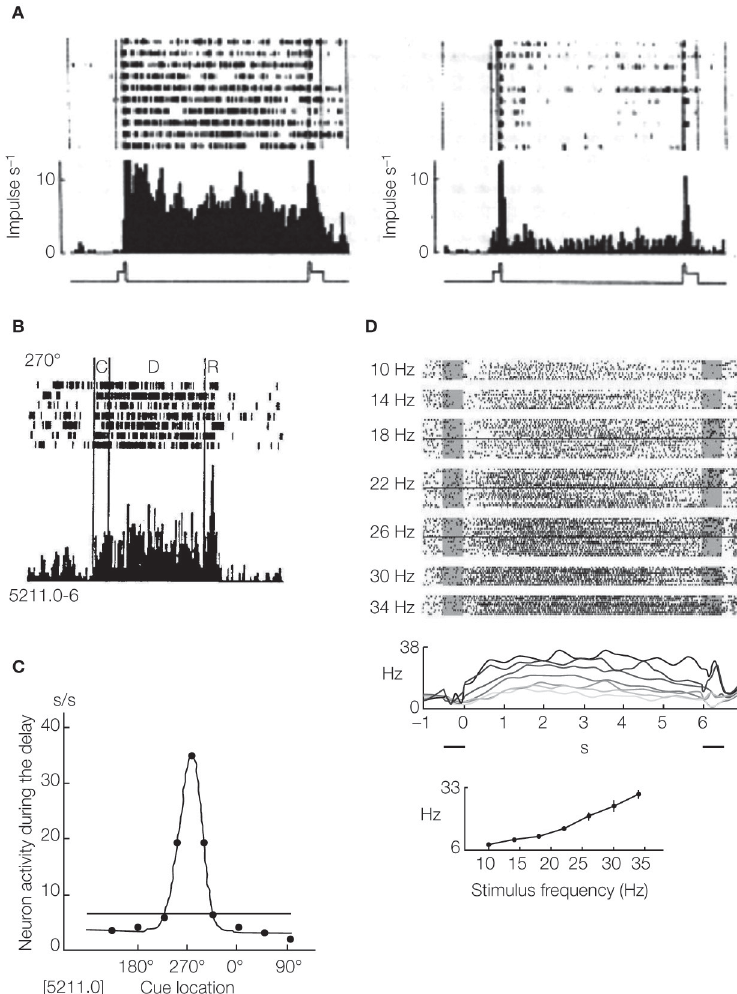
Figure 1 | Experimental evidence of persistent activity. (A) Persistent activity of a cell in IT cortex of a monkey performing a DMS task. Raster and trial-averaged fi ring rate of in trials during which the picture that elicits the highest delay activity is shown as a sample ( left ) and trials when an unfamiliar picture is shown ( right ). From Miyashita (1988), reprinted by permis- sion from Nature, © 1988 Macmillan Publishers Ltd. (B) Persistent activity of a cell in PFC of a monkey performing an ODR task. Raster and trial-averaged fi ring rate of a neuron when a cue is presented at 270 ( top panel ), the preferred cue location for that neuron ( C : cue period; D : delay period; R : response period). From Funahashi et al. (1989), used with permission. (C) average fi ring rate during the delay period vs. cue location, for the neuron shown in (B) . From Funahashi et al. (1989), used with permission. (D) Persistent activity of a cell in PFC of a monkey perform- ing a delayed somatosensory discrimination task. Top panel : Rastergrams of a PFC cell arranged according to frequency of the base stimulus (indicated on the left). Middle panel : Trial averaged fi ring rate for several stimulus frequencies showing the monotonic response as a function of stimulus frequency. Bottom panel : Tuning curve of the cell in the delay period. From Romo et al. (1999), reprinted by permission from Nature, © 1989 Macmillan Publishers